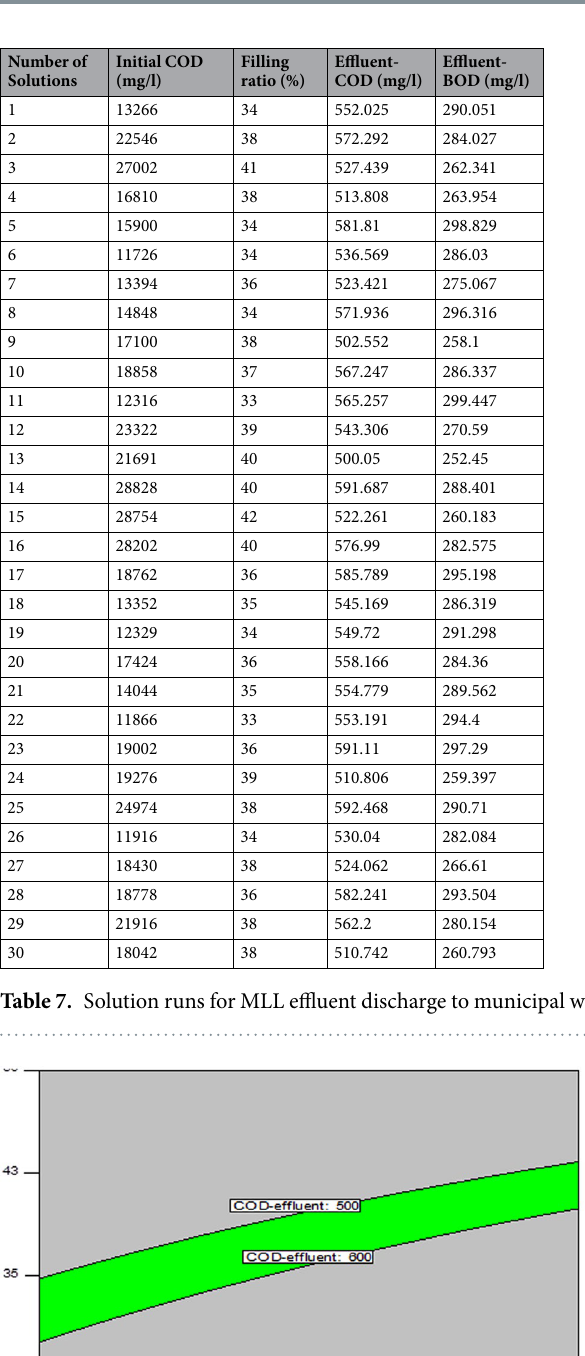
Figure 6. Effluent optimization for effluent discharge to municipal wastewater collection